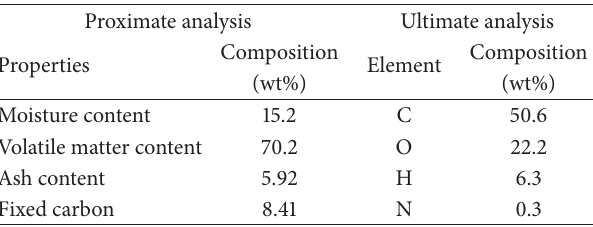
Table 1: The composition of pinewood in terms of proximate and ultimate analyses.